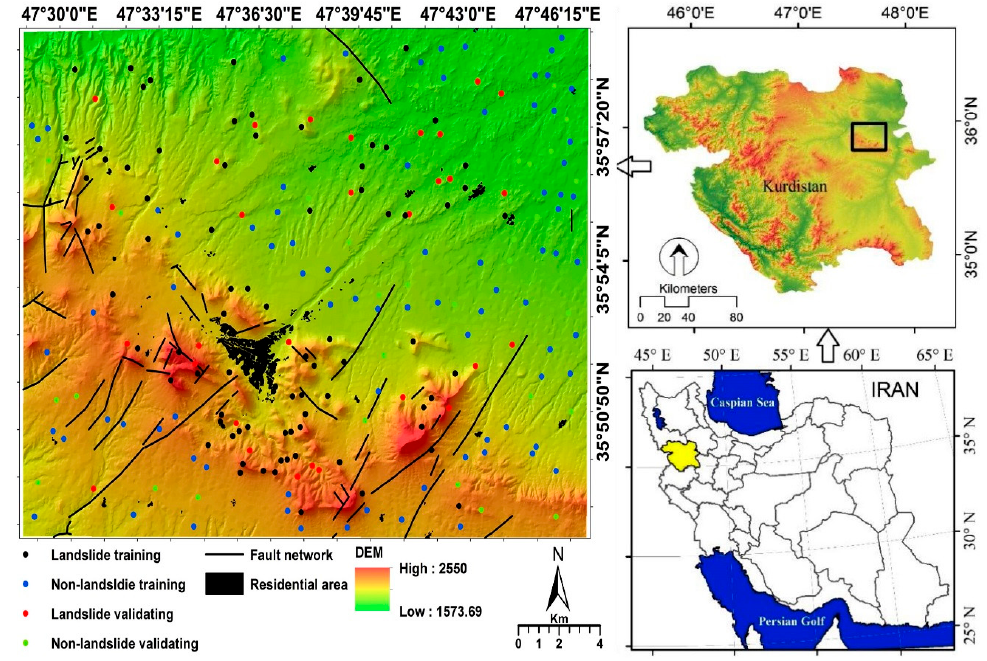
Figure 1. Study area and locations of landslides in Bijar County, Kurdistan, Iran.